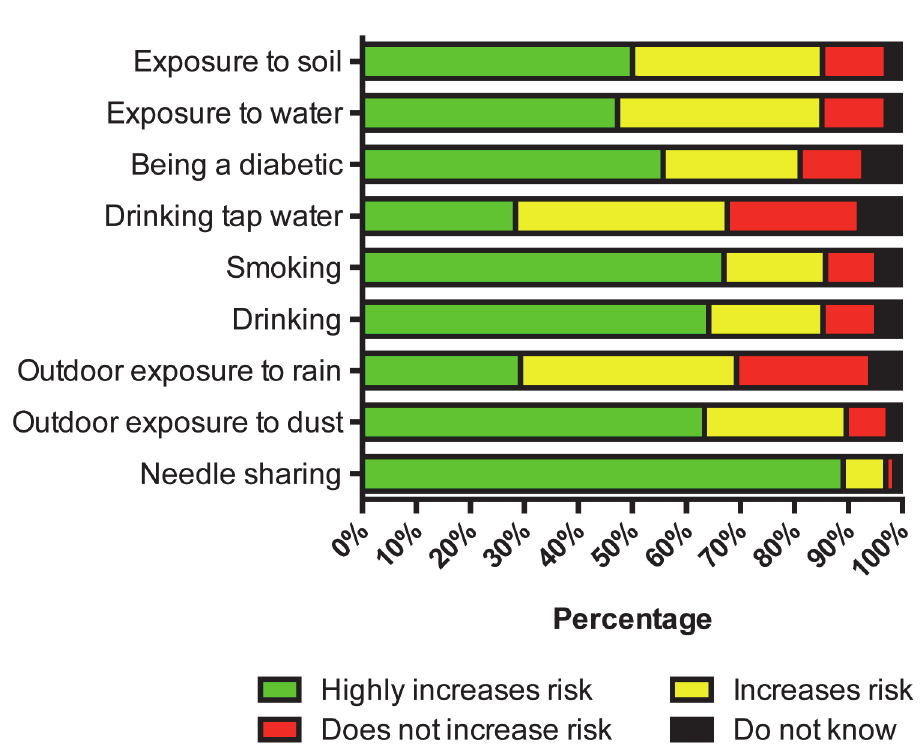
Fig 2. Knowledge about risk factors for common infectious diseases in Thailand (n =